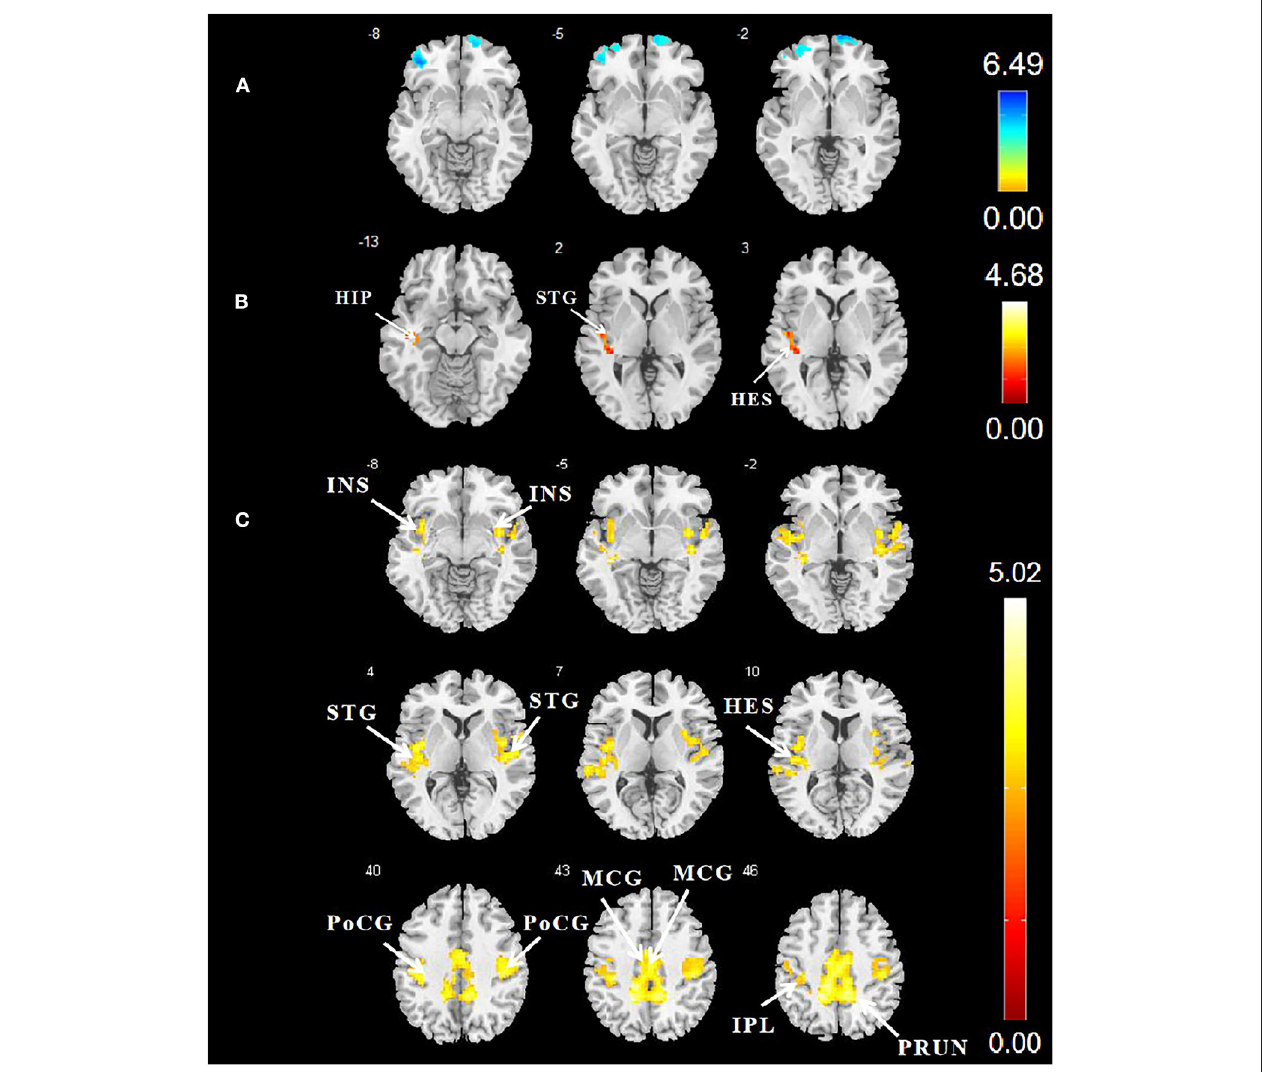
FIGURE 1 | (A) Differences in GMV between patients with early-onset T2DM and HCs. AlphaSim correction (5,000 simulations, voxel p = 0.001, and cluster size ≥ 586 voxels). (B) Comparison of DC values between the two groups. Cluster-level FWE correction ( p < 0.05, cluster size ≥ 80 voxels). (C) Comparison of FC values between the two groups. Cluster-level FWE correction ( p < 0.05, cluster size ≥ 90 voxels). The color bar denotes the t -value. GMV, gray matter volume; T2DM, type 2 diabetes mellitus; HCs, healthy controls; DC, degree centrality; FWE, familywise error; FC, functional connectivity.